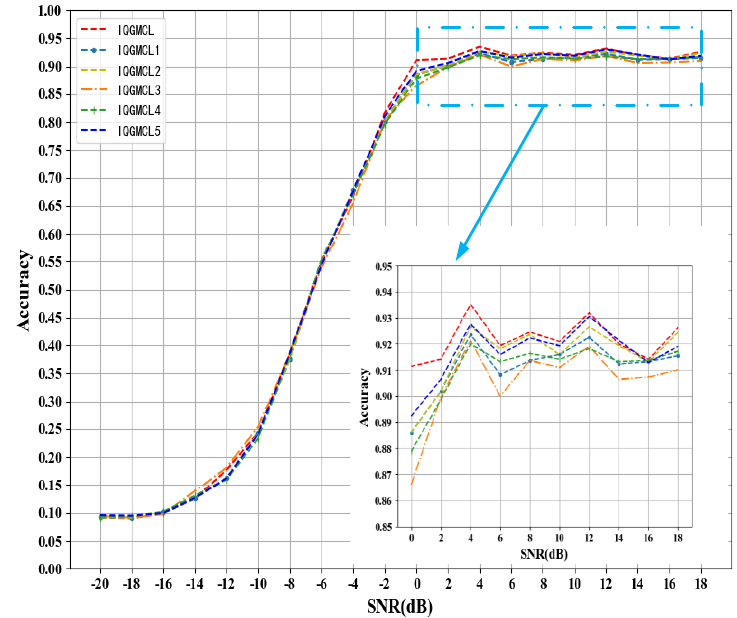
Figure 5. Comparison chart of each improvement network experiment.